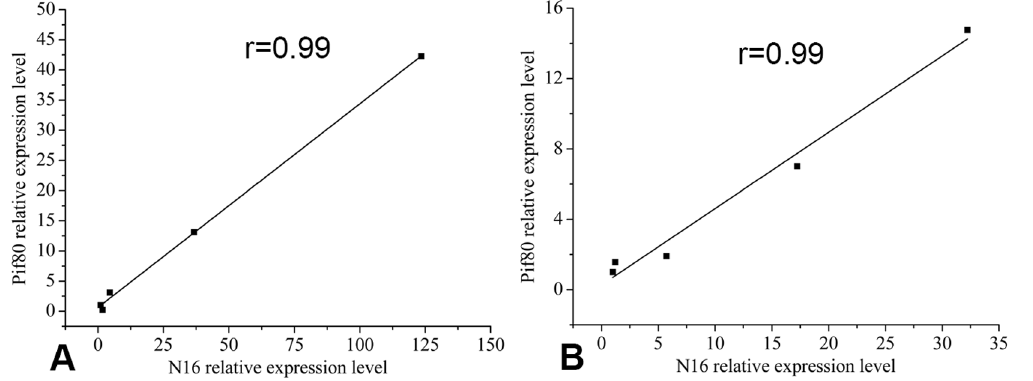
Figure 5. Correlation of gene expression levels between N16 and Pif80. (A) in the inner-shell film system, (B) in the film-free system. A significant correlation was observed between N16 and Pif80. r, correlation coefficient